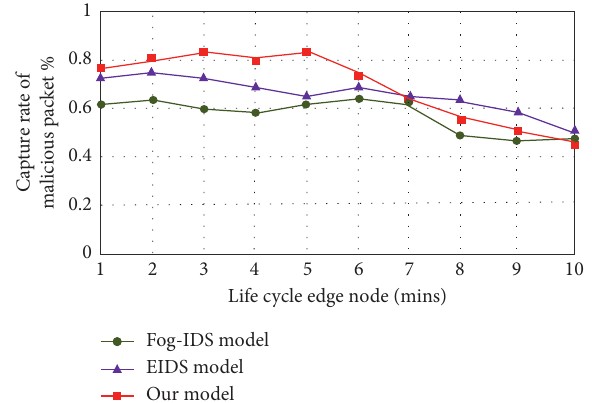
Figure 12: Malicious packet capture rate under ( τ , υ ) � ( 0 . 3 , 0 . 5 ) .